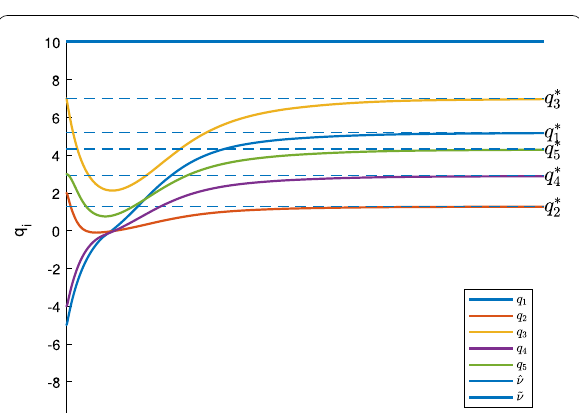
Figure 8 The tracking errors along with the imposed boundaries